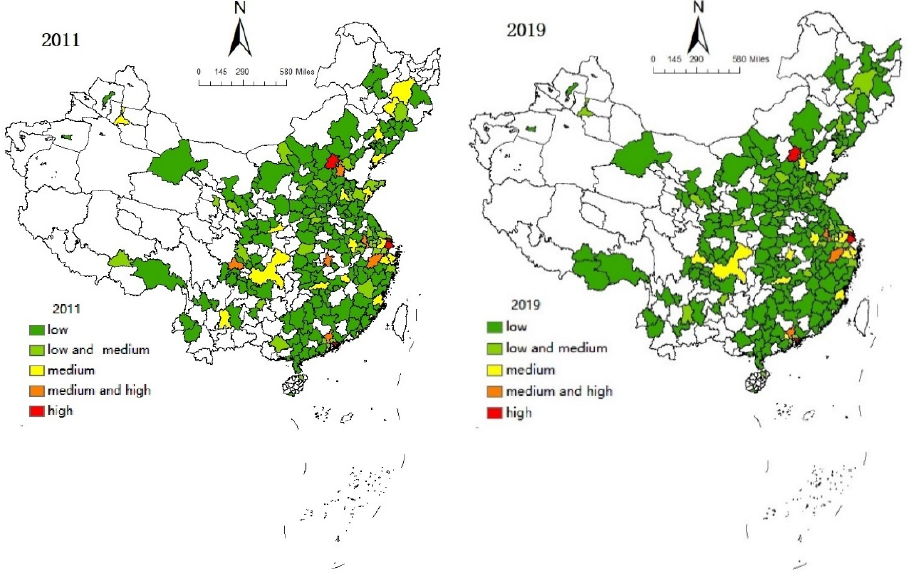
Figure 2. Trends in agricultural productivity from 2011 to 2019.